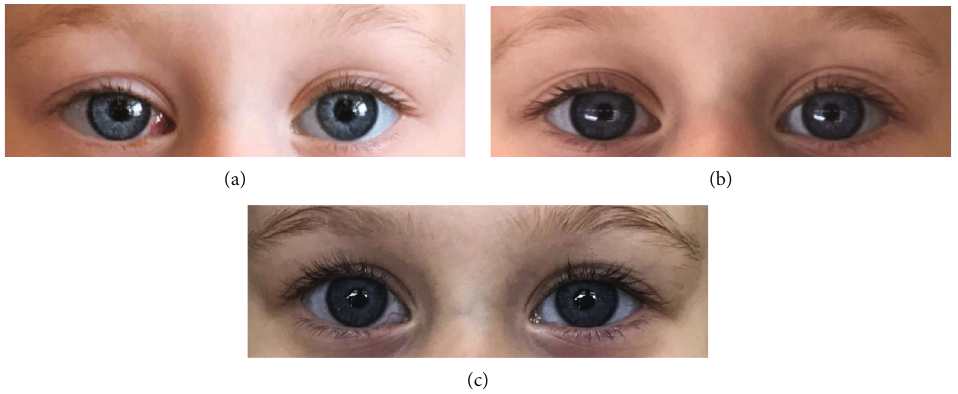
Figure 2: (a) Postoperative fi rst-week photo with orthotropia. (b) The second photo at 6 months with no recurrence or over-/ undercorrection. (c) The last photo at 9